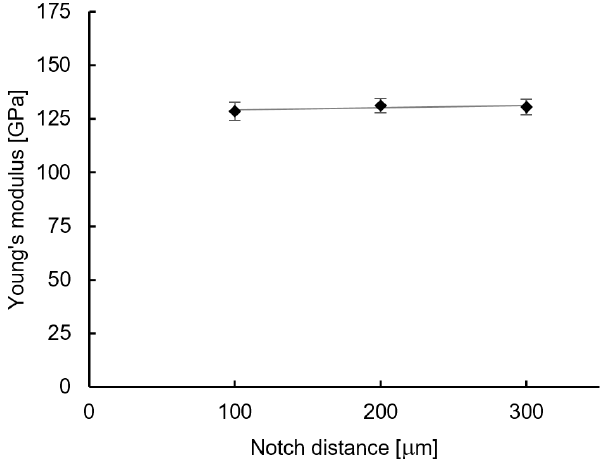
Figure 12. Average values of Young’s modulus and standard deviation for z-pinned reinforced unidirectional carbon/epoxy composites with notched z-pins, circumferentially notched with rectangular notch design with constant notch width of 100 µ m and notch depth of 20 µ m, at different notch